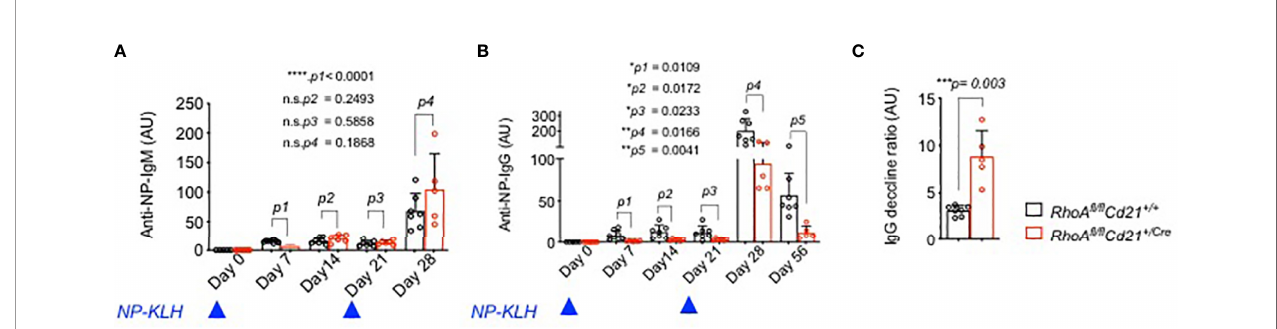
FIGURE 8 | Impairedhumoral immune response of RhoA fl / fl Cd21 +/Cre mice. ( A ) Six-eight weeksold RhoA fl / fl (N=7) and RhoA fl / fl Cd21 +/Cre (N=8) mice were immunized with 100µg NP(24)KLH+ 100µgCpG-ODN1826 in PBS or with 100µgCpG-ODN1826 (control). Serum level ofNP speci fi c IgM (A) and IgG (B) antibodies were measured by ELISA at thespeci fi ed daysafter fi rst immunization (day 0) and booster onday 21. No NP-speci fi c antibodies were detectedin control mice injectedwith adjuvant (CpG- ODN1826) henceexcluded from the fi gure. Statistical analysis- One-way ANOVA. (C) The decline of anti-NP-IgG titerswas calculatedas the ratio of IgG titers at day 28 relative to day 56. Statisticalsigni fi cance was determined using unpaired t-test, two-tailed.*p<0.05, **p<0.01, ***p< 0,001, ****p<0.0001, ns- not signi